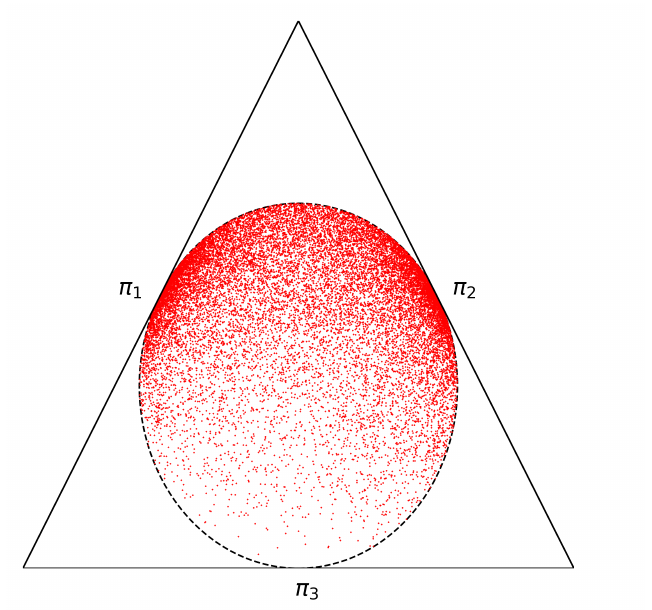
Figure 4. Dalitz plot for double ionization. The ternary variables are described in the